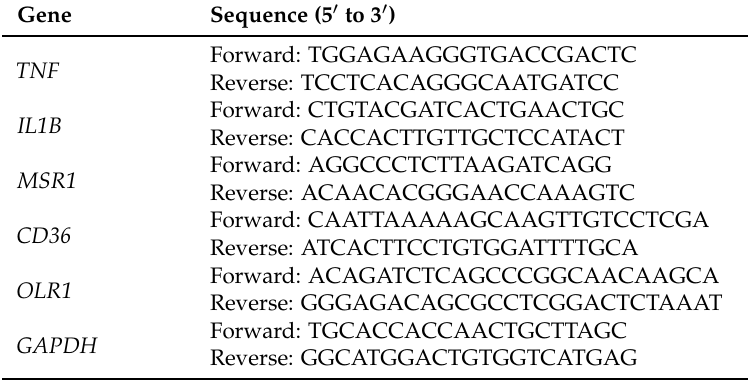
Table 1. Primer sequences used for the analysis of TNF , IL1B , MSR1 , CD36 , OLR1 and GAPDH .